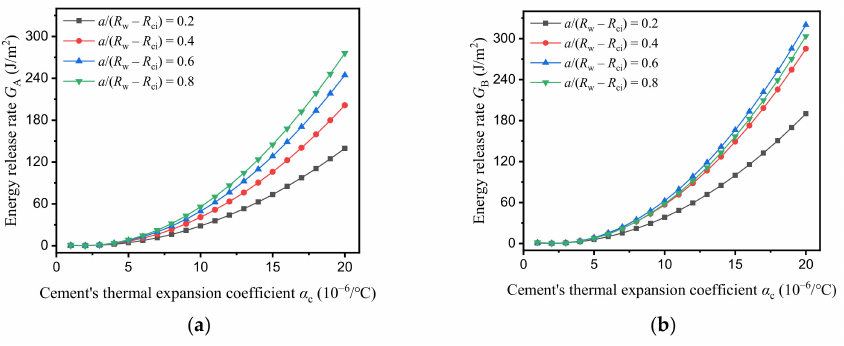
Figure 10. Evolution of the energy release rate at the radial crack tips with due to the thermal expansion coe ffi cient of the cement: ( a ) crack tip A; ( b ) crack tip B.